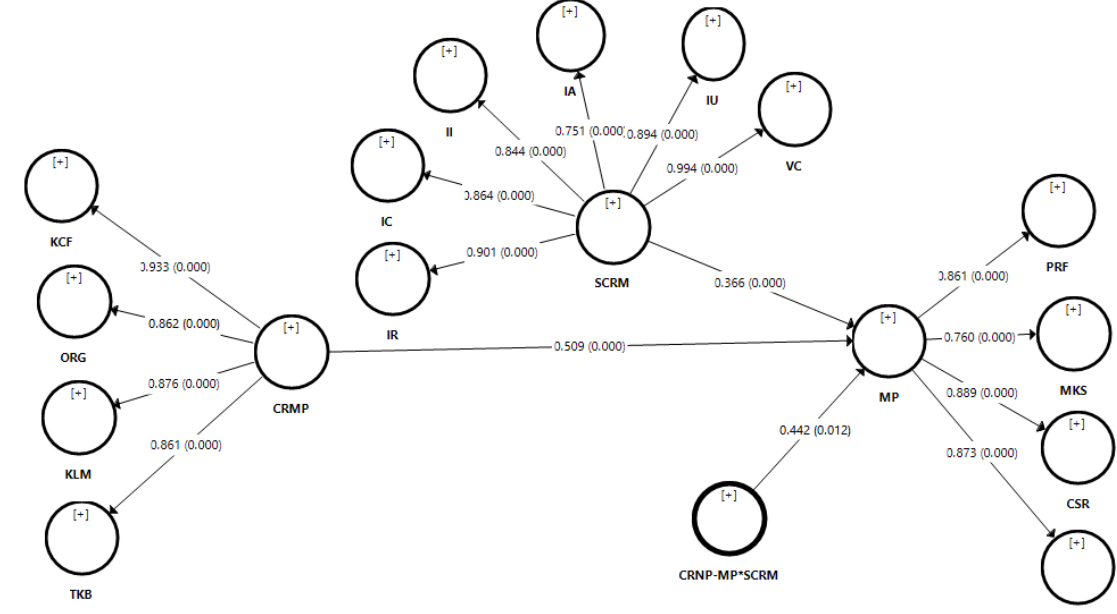
Fig. 2. Path Model